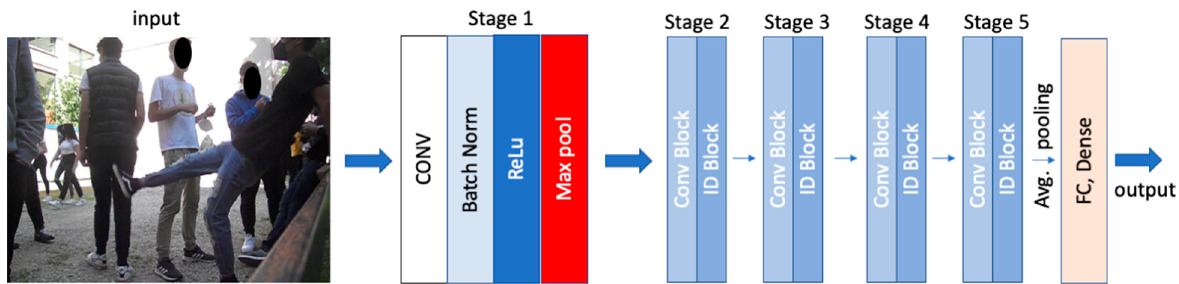
Figure 2. ResNet-50 architecture is a Convolutional Neural Network with 50 deep layers. It uses a bo tt leneck design: convolutions reduce the number of parameters and matrix multiplications enable faster training of each layer. Every convolutional layer is followed by a batch normalization layer, a ReLu activation function and a max pooling layer. Then, ResNet block transforms the input into the desired shape for the addition operation passing it through the next stages (residual blocks). At the fi nal stage, average pooling followed by a fully connected layer works with a softmax activation function.